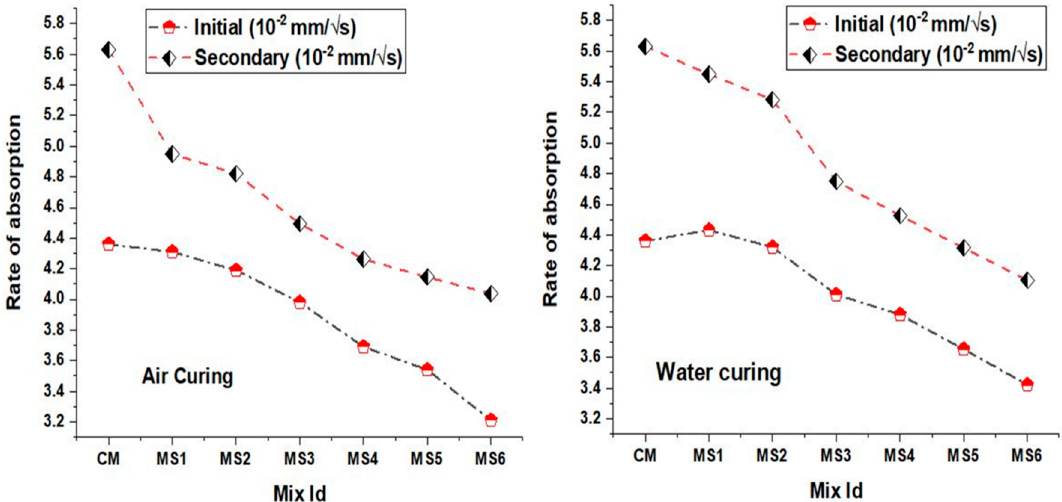
Figure 10. Rate of absorption of the air cured and water cured polymer concrete mixes